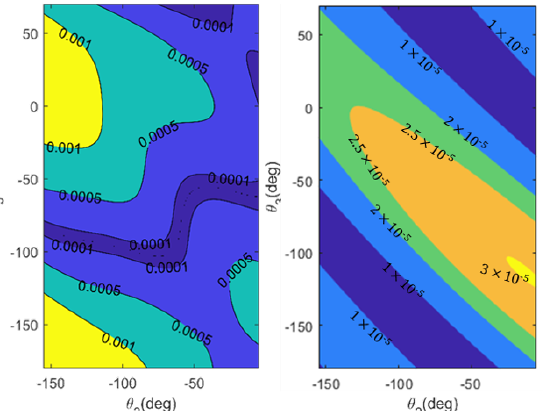
Figure 10. Contour map of ( a ) f p and ( b ) f r under the two